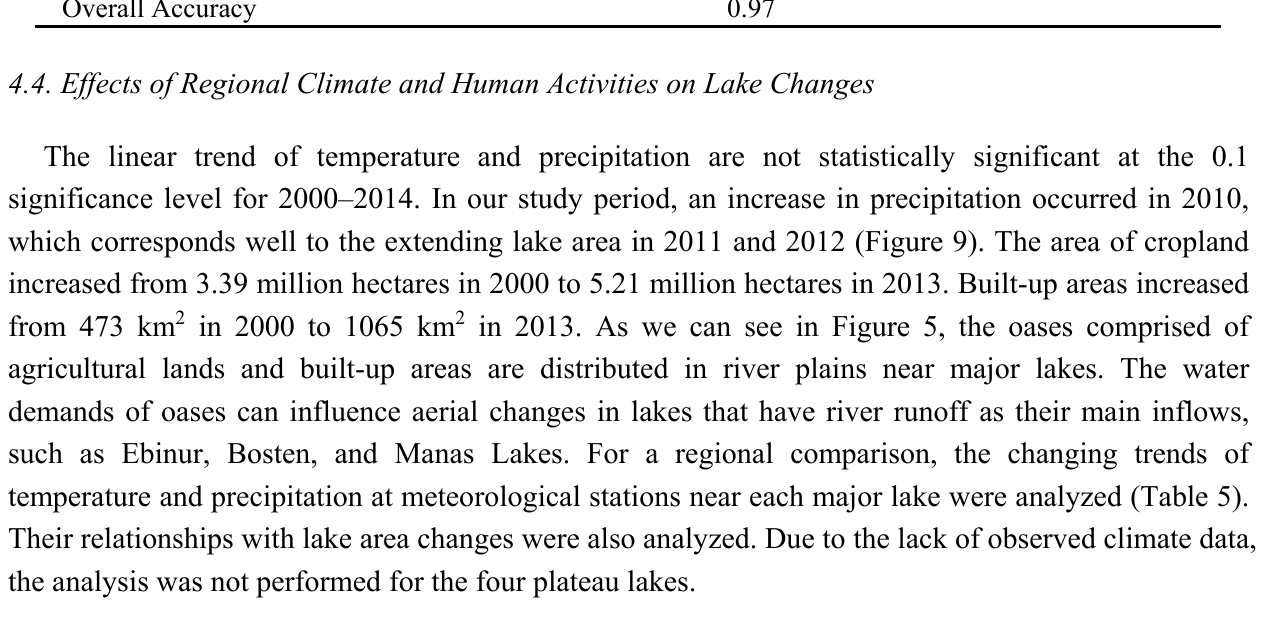
Figure 8. Comparison of a water body derived from MODIS data and Landsat for April 2014, Ulungur Lake. ( a ) Landsat image; ( b ) water mask derived from Landsat data; and ( c ) water mask derived from MODIS data. Table 4. The error matrix, overall, producer’s, and user’s accuracies of water bodies and non-water bodies resulting from MODIS time series data, 2000–2014. Bosten